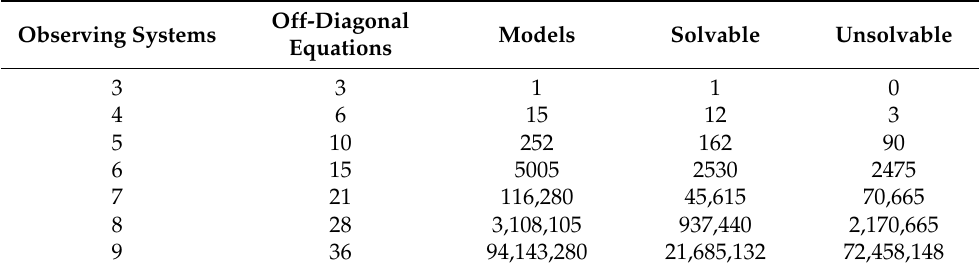
Table 1. Number of observing systems, number of equations, number of models, and number of solvable and unsolvable